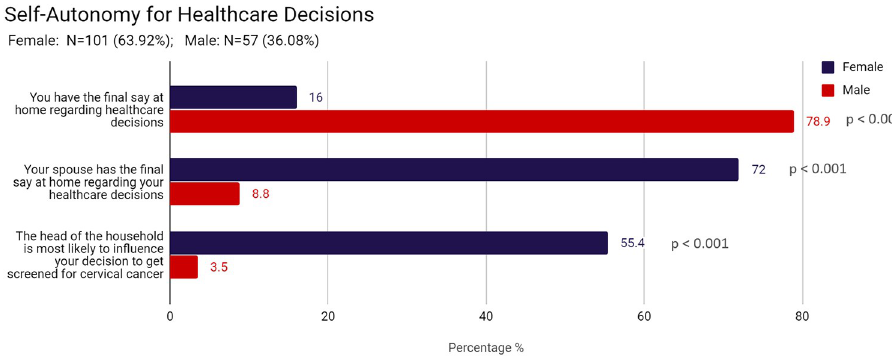
Fig 2. Self-autonomy for healthcare